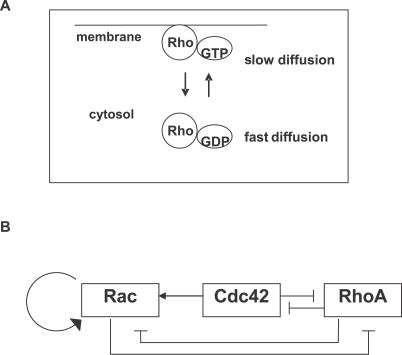
A Reaction–Diffusion Model of the Rho GTPases(A) The Rho family of GTPases, which are localized in the membrane (GTP-bound active forms) or cytosol (GDP-bound inactive forms), has conserved mass and shows slower diffusion in the membrane than in the cytosol.(B) Diagram of the model with the Rho GTPases. Arrows and bars indicate the stimulatory and inhibitory interactions, respectively.